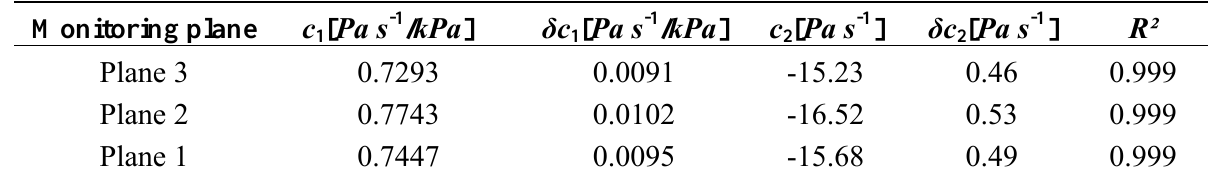
= ( c ± δ c ) p + ( c ± δ c ) in Figure 3 ( c 1 1 1 O2 2 2 , R² – correlation i